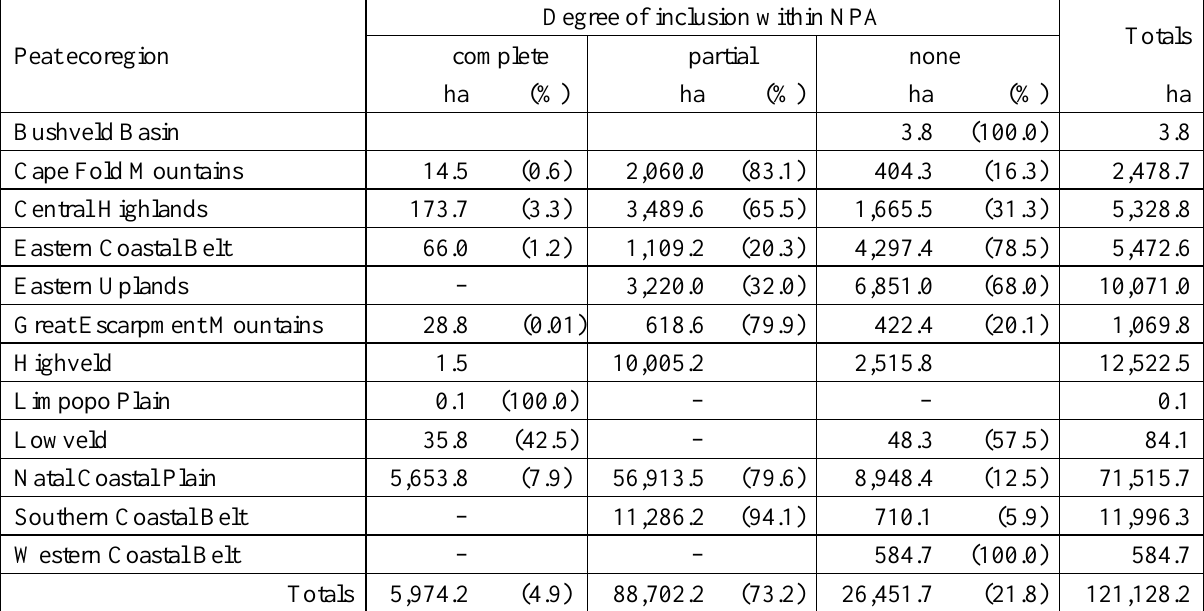
Table 5. Extent of peatlands within National Protected Areas (NPAs) across peat ecoregions of South Africa. Degree of inclusion within Peat ecoregion